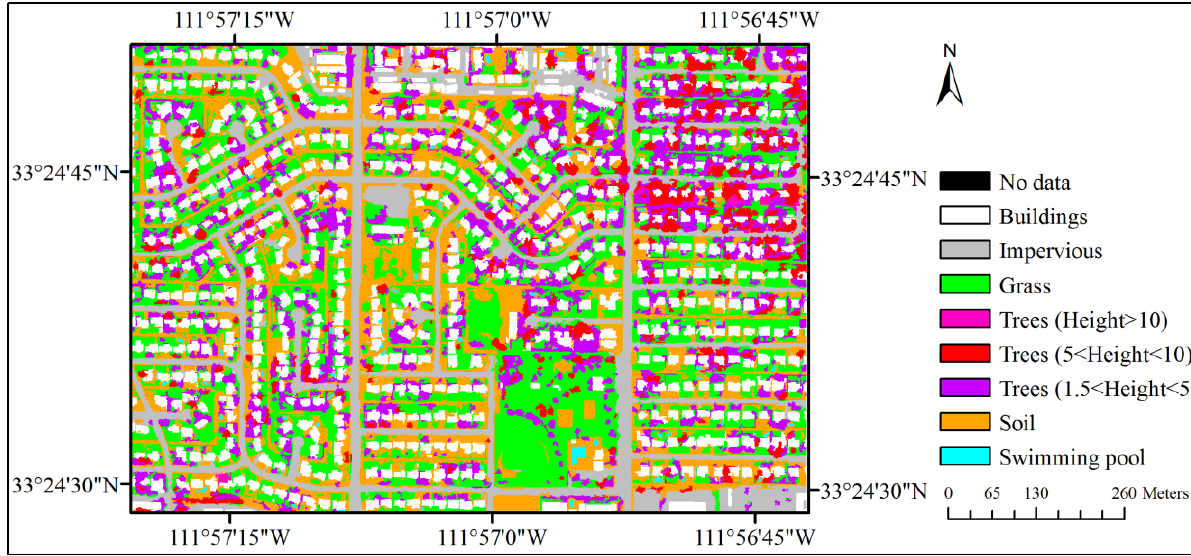
Figure 8. Decision rules for object-oriented classification.